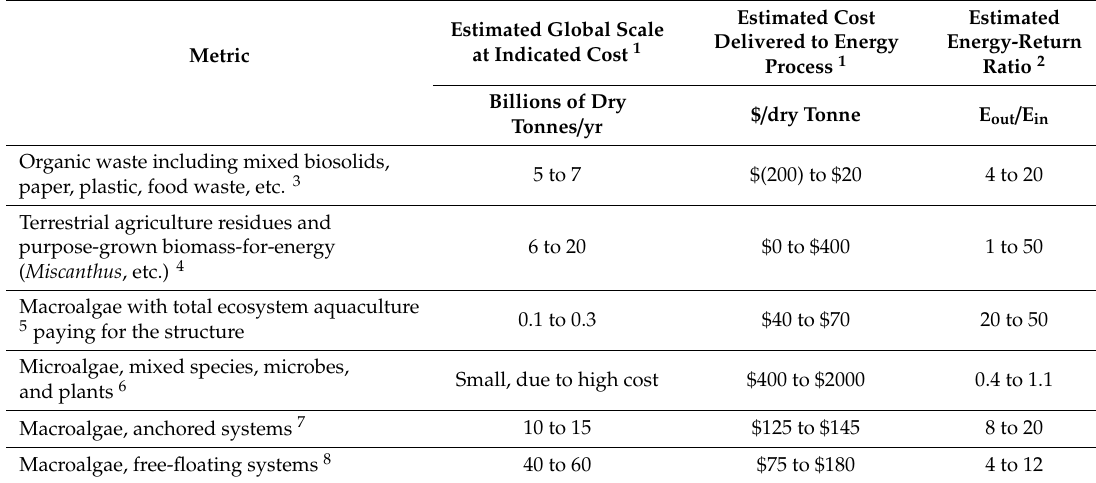
Estimated Estimated Cost Estimated Global Scale Delivered to Energy Energy-Return at Indicated Cost 1 Ratio 2 Process 1 Billions of Dry $ / dry Tonne E out / E in Tonnes / yr 5 to 7 $(200) to $20 4 to